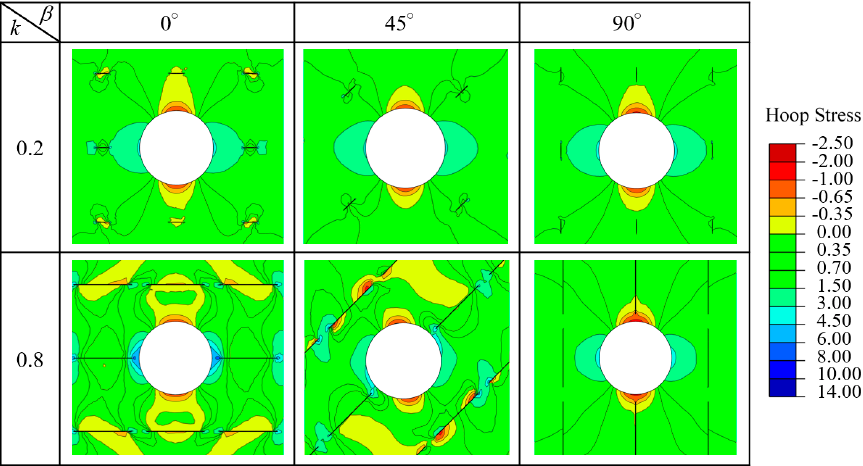
Figure 23. Hoop stress distribution at σ 1 = 1 MPa in specimens with k = 0.2 and 0.8 at β = 0°, 45° and 90°.